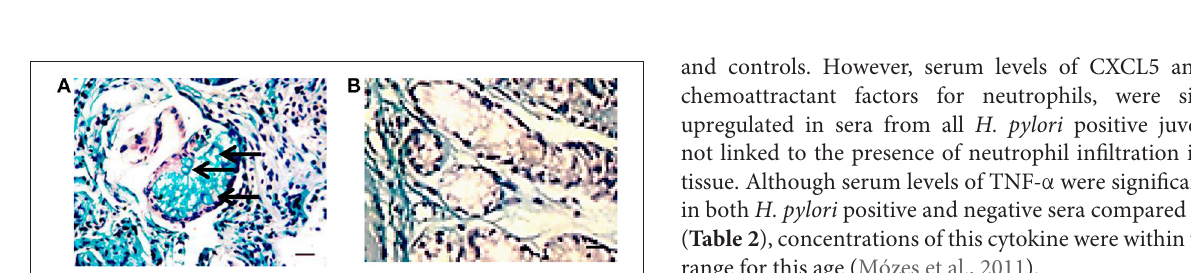
FIGURE 1 | Histological sections of three representative biopsies. Gastric biopsy sections (3–5 µ m) of control (A) , and H. pylori positive (B) and H. pylori negative (C) gastroduodenitis cases were deparaffinized and stained with hematoxylin and eosin (H&E). The gastric epithelium phenotype of the H. pylori positive juvenile (B) resembles the phenotype of colonic epithelium, characterized by multiple intracytoplasmic mucin droplets of varying sizes and shapes (solid arrow), and the absence of a brush border (dashed arrow). H&E; x100; Bar represents 20 µ m.